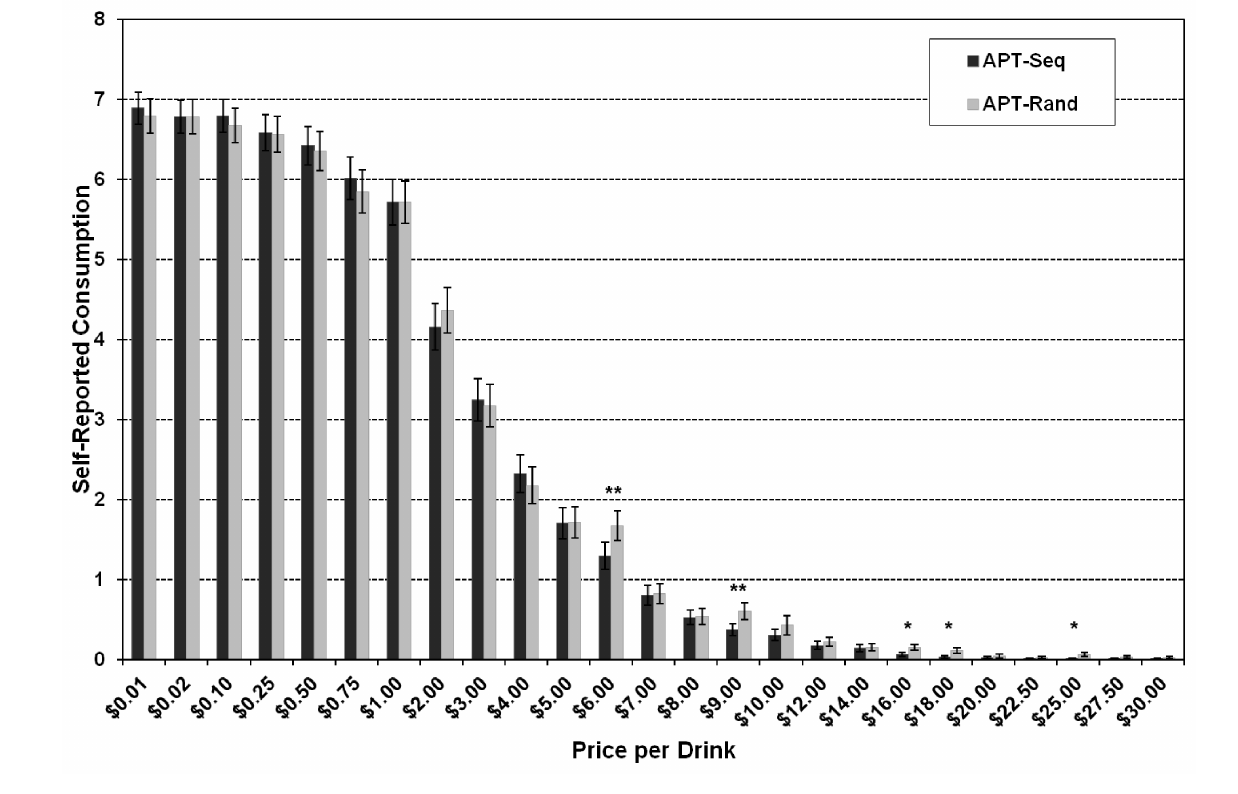
FIGURE 1 | Self-reported alcohol consumption by price across sequential (APT-Seq; dark gray bars) and randomized (APT-Rand; light gray bars) versions. Individual bars represent mean ( ± standard error). Note, N = 91; * p < 0.05; ** p <